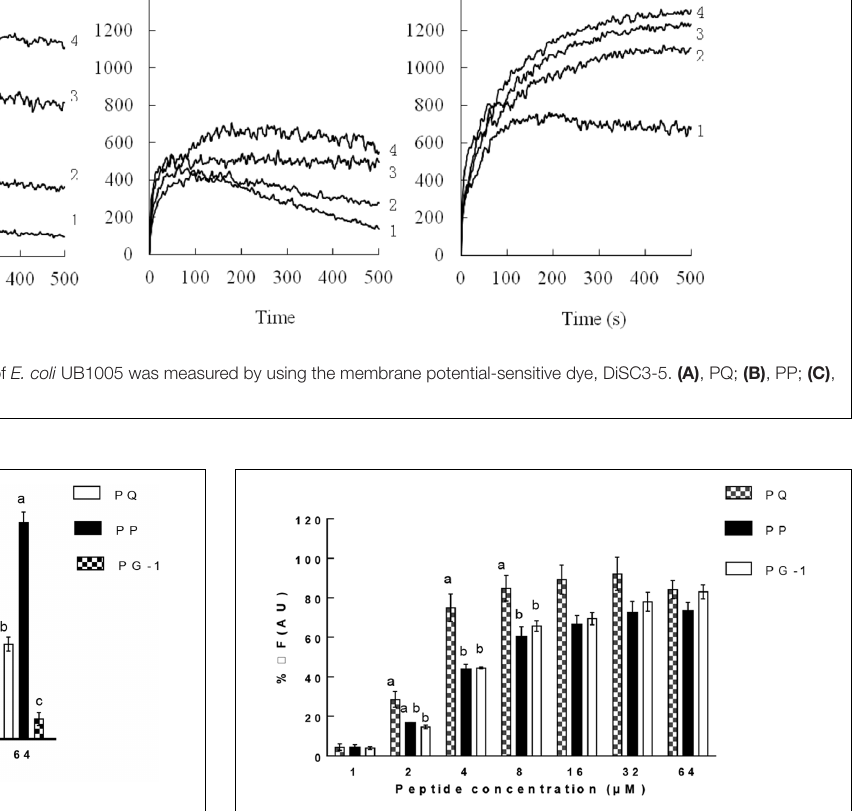
FIGURE 9 | Peptide binding affinity to LPS from E. coli 0111: B4. The graphs were derived from average of three independent trials. Means in the same concentration with different superscript indicate a very significant difference ( P <